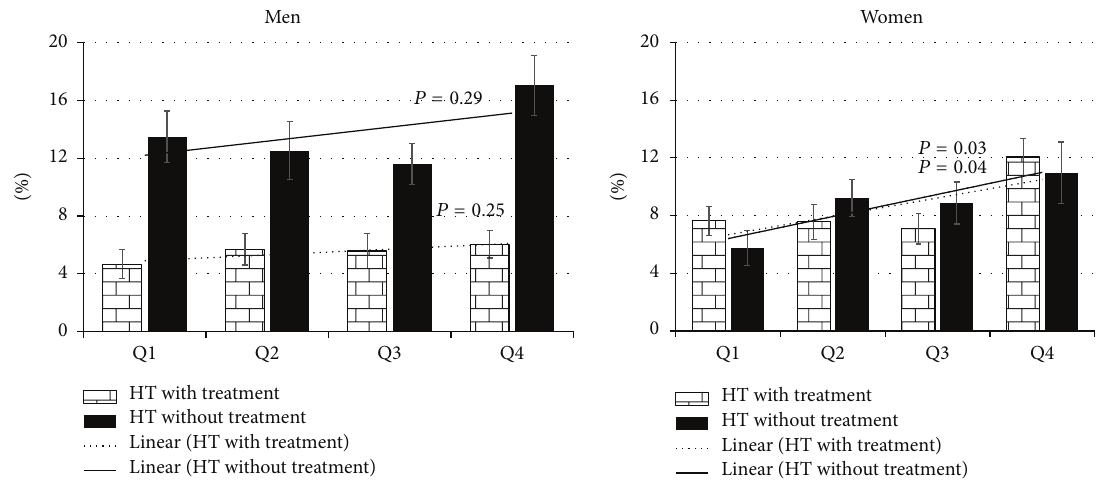
Figure 1: Age-adjusted percentages of hypertension with and without treatment by quartile of BPA level in men and